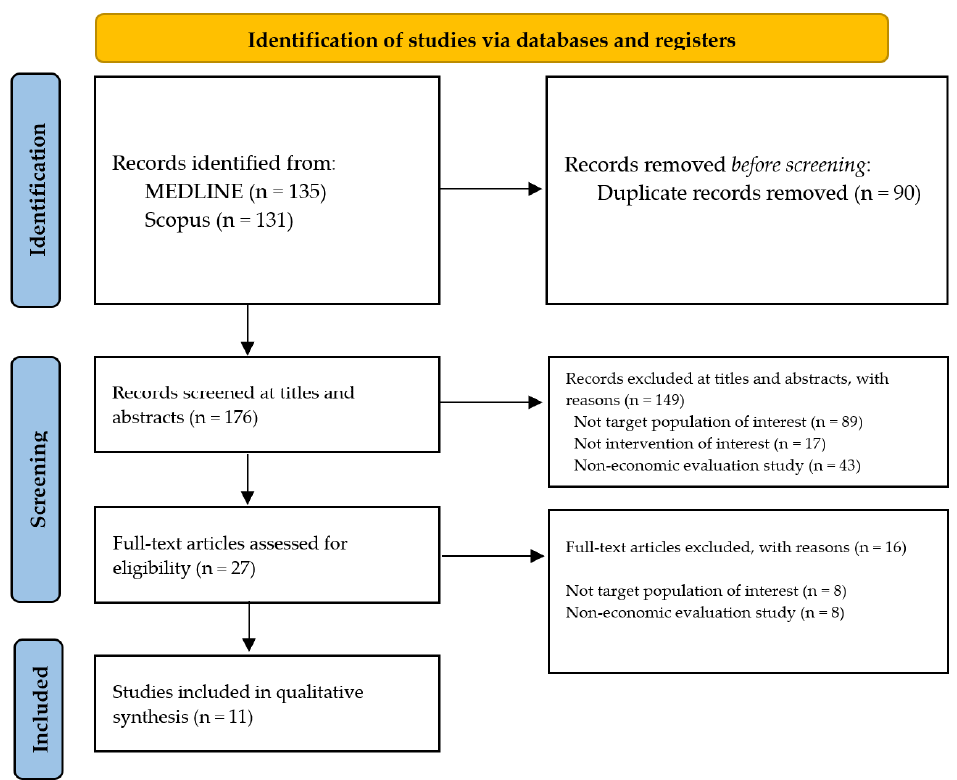
Figure 1. Flow diagram and references of included studies.